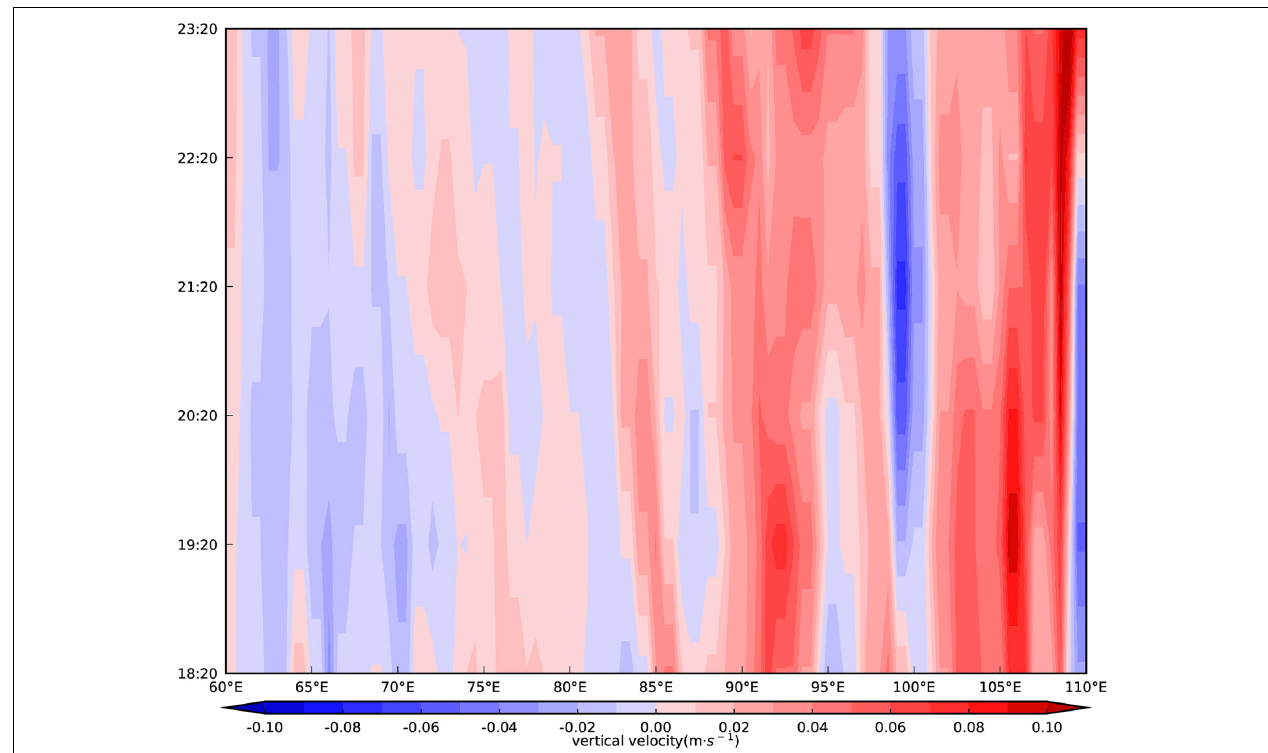
FIGURE 10 | The time evolution of vertical velocity (unit: m s − 1 ) with longitude over 28 ◦ N simulated by WRF for the period 18:20–23:20 on 3 May, 2014 at 200 hPa.